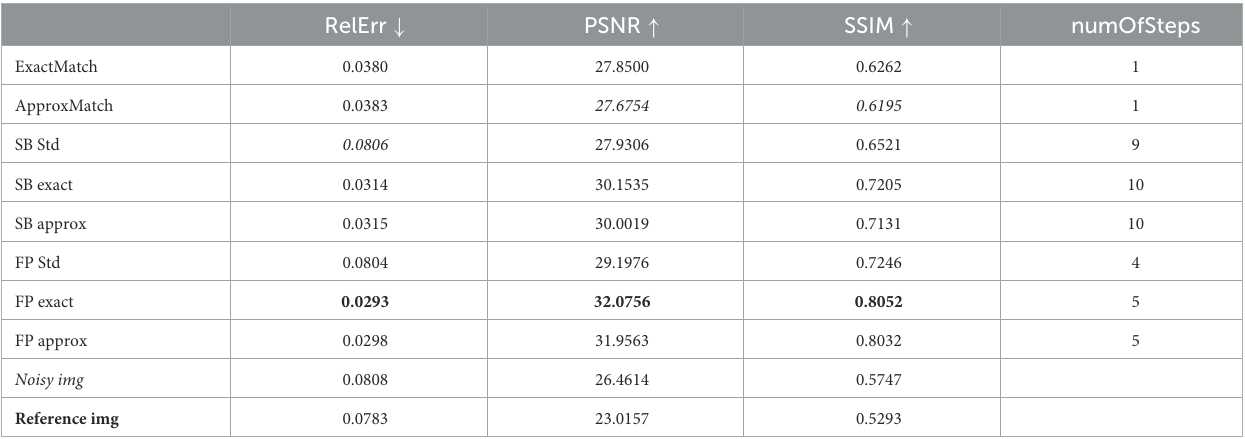
TABLE 4 Case 4 is another realistic case in which the target image is retrieved with 9% noise at a distance of +5 mm from the original image, which also has 3%